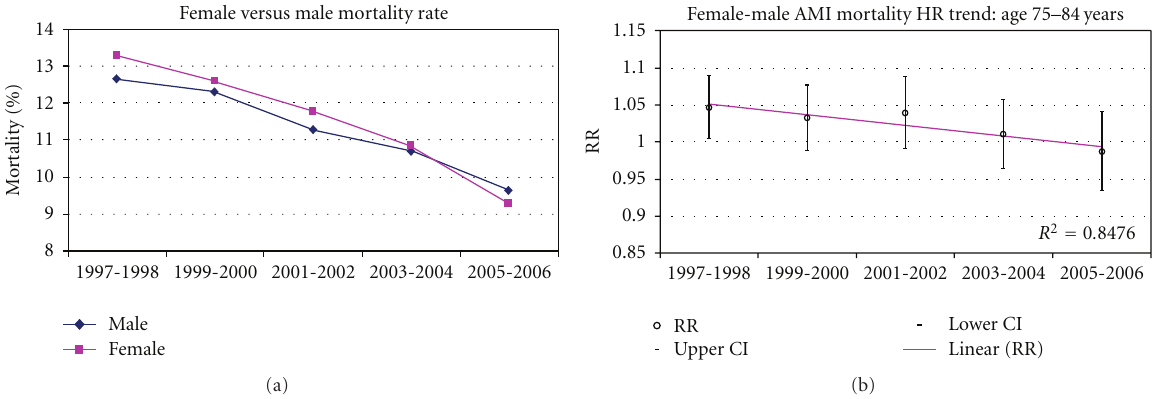
Figure 4: In-hospital AMI mortality rate and relative mortality trend (female versus male) by NIS year for age 75–84 years